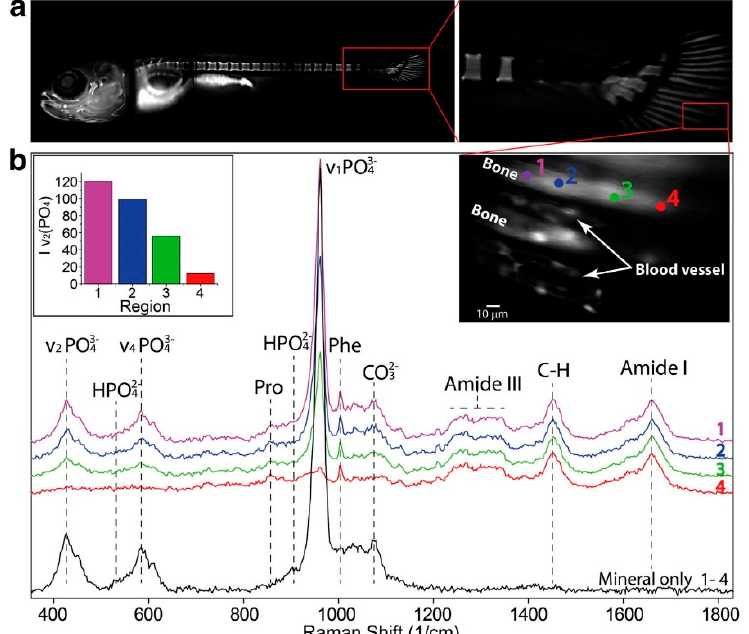
Figure 4. Correlative fluorescence–Raman imaging of zebrafish fin bone maturation. ( a ) Low-resolution (10 × ) fluorescence image of zebrafish stained with calcein green, with high-resolution (60 × ) details (right inset in panel b) of a representative fin ray region where Raman spectra ( b ) of progressively mineralized bone tissues were acquired (numbered 1–4). (Left inset in panel b) Integral of the orientation independent mineral band (v 2 ) where a clear drop of the mineral content can be observed. Reproduced from reference [83].